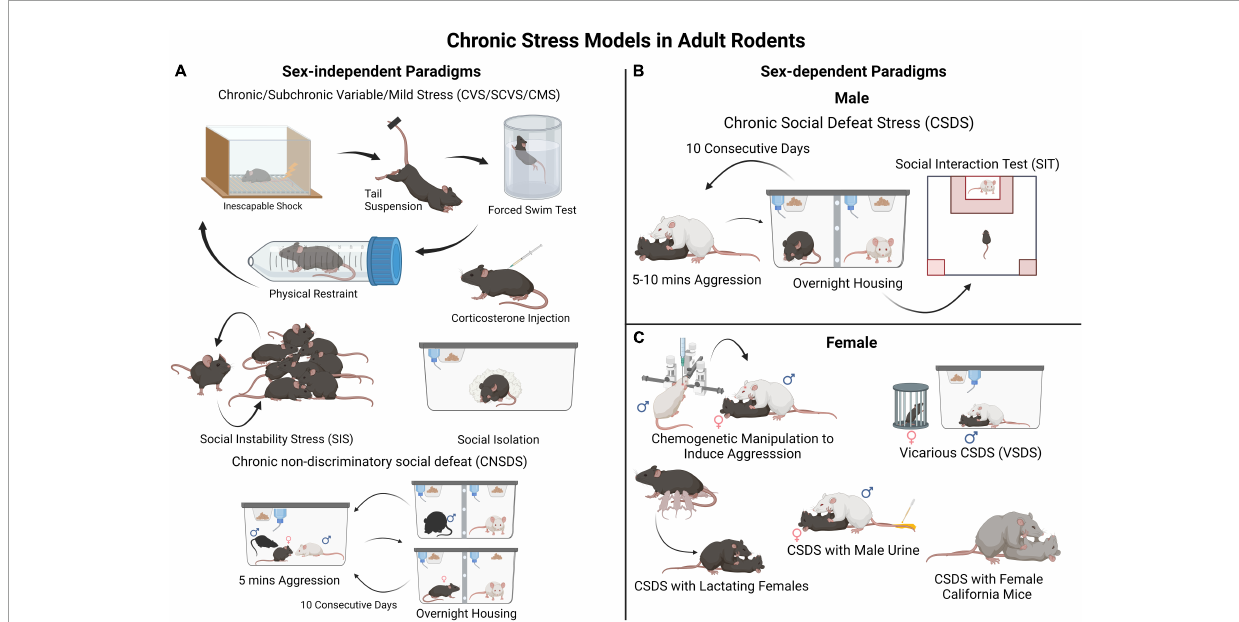
FIGURE1 Rodent models for chronic stress-induced depression-like behaviors. (A) These are examples of commonly employed sex non-specific paradigms such as different variations of chronic/subchronic variable (mild) stress (chronically exposing the experimental animals to different stressors in random order), social instability stress (disturbances in an animal’s social hierarchy), social isolation, and corticosterone administration. These can be used in both male and female mice to investigate biological sex-mediated mechanisms in stress vulnerability. In these paradigms animals are not segregated into resilient and susceptible groups, thus examination of individual differences in stress susceptibility is limited. (B) A widely used and validated model of chronic stress in male mice is CSDS. In this procedure, control animals are housed with a conspecific and a divider that allows sensory stimuli. Each experimental male mouse is exposed to a social defeat session (for 5–10 min each day) in which the mouse is socially defeated by an aggressive CD-1 mouse for several (often 10) consecutive days. After the CSDS, all mice are assessed in a social interaction test to evaluate their sociability toward a social target (e.g., a novel CD-1 mouse). This will classify each experimental mouse in either susceptible or resilient phenotype. (C) A major limitation of the CSDS model is that female mice are not readily attacked by an aggressor CD-1 mouse. Thus, the CSDS model has needed to be adapted for female mice. A few different approaches have been described, such as a modified version of CSDS involving Swiss Webster female mice (Newman et al., 2019; Williams et al., 2022) and CSDS with lactating females, (Bourke and Neigh, 2012; Jacobson-Pick et al., 2013) both shown to induce behavioral deficits in female mice. However, the defeated mice are not segregated into resilient and susceptible groups, which limits in-depth assessment. An additional paradigm involves marking female experimental mice with male urine to induce